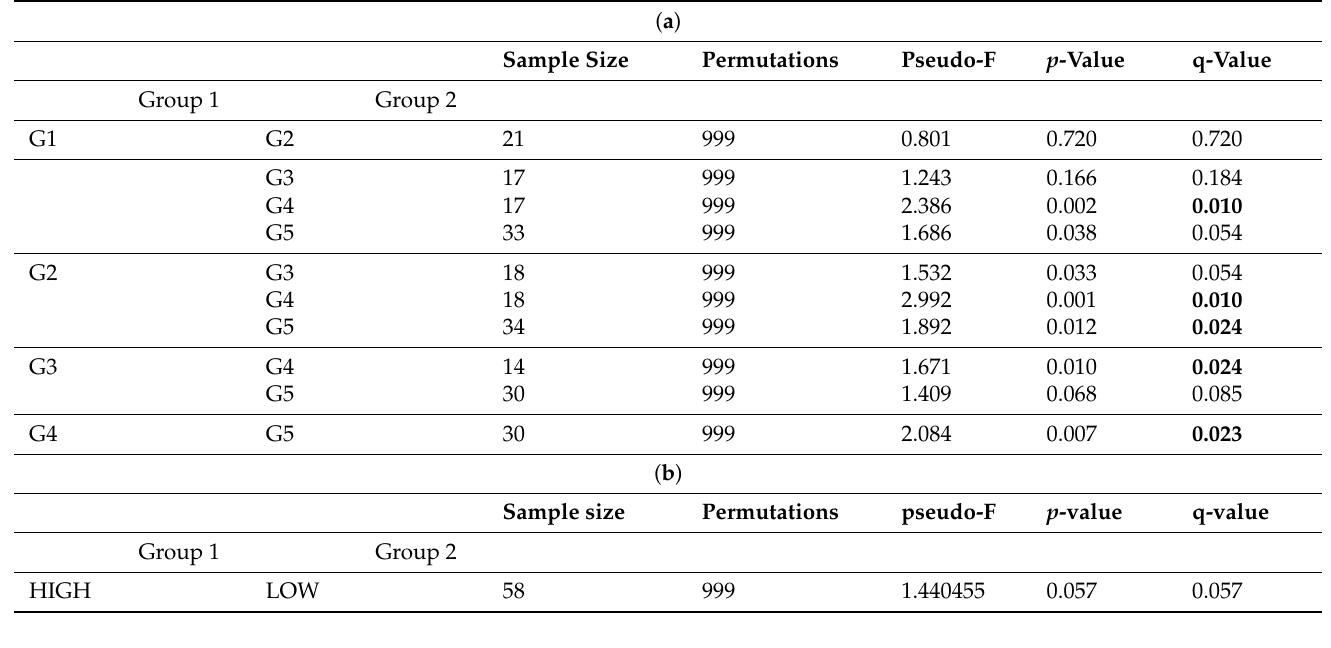
Table 1. Pairwise PERMANOVA results. ( a ) Group comparisons regarding geographic origin; ( b ) Group comparisons regarding high and low alkalinity. Bold values indicate q < 0.05.